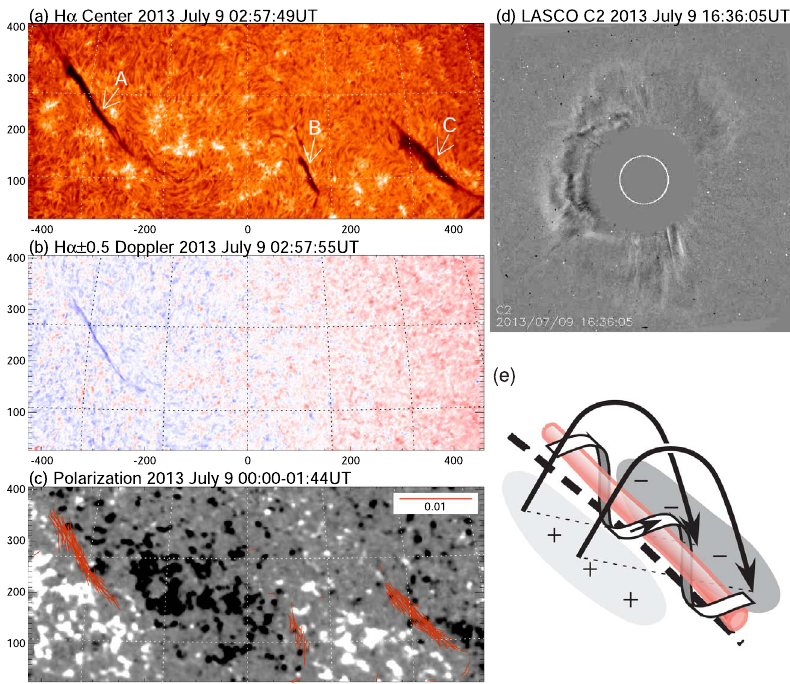
Fig. 6. Filament observed before its eruption and CME occurring on July 9, 2013. (a) and (b) The fi lament before its eruption observed with the SFT. Panel (a) shows a H a line center image, and (b) shows a Dopplergam based on the H a ± 0.05 nm images. Blue and red shifts of the H a line are shown in corresponding colors. Three fi laments are seen in panel (a), where the one on the left labelled “ A ” erupted later. (c) A polarization map including the fi lament before eruption taken with the SFT. Red lines show the linear polarization signals of He I 1083.0 nm; the length of each line indicates the degree of the corresponding linear polarization signal (the line in the inset corresponds to the polarization of 0.01 [1%]), and its direction indicates the orientation of the polarization signal. Only the linear polarization signals > 0.1% are shown. The background gray-scape map shows the circular polarization of Si I 1082.7 nm; the display range is ± 1%. (d) A halo CME seen after the fi lament eruption observed using the LASCO C2 of SOHO, of which the fi eld of view covers up to 6 solar radii. (h) Schematic representation of the magnetic fi eld structure around the erupted fi lament. The red bar represents the fi lament material, and helical magnetic fi eld of the fl ux rope surrounds it. Coronal magnetic loops connect large scale positive and negative polarities on the